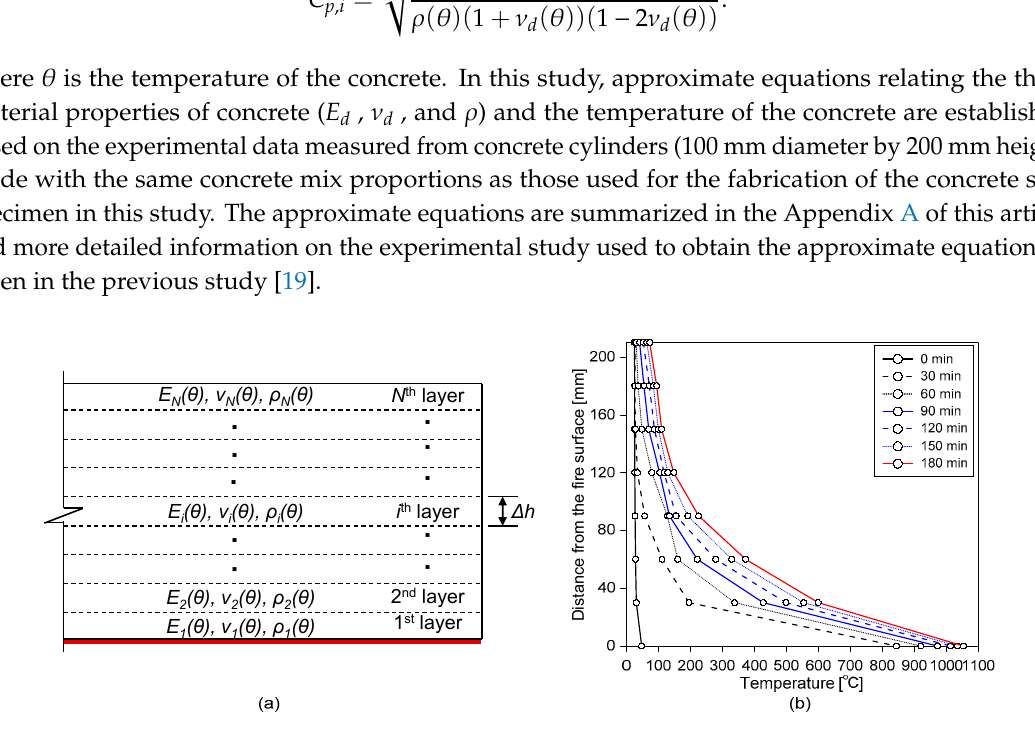
Figure 14. Summary of the estimated P-wave velocity profile in fire-damaged concrete slabs: ( a ) illustration of a discrete layer model for a fire-damaged concrete slab, and ( b ) measured temperature within the fire-damaged concrete during the fire test in this study.